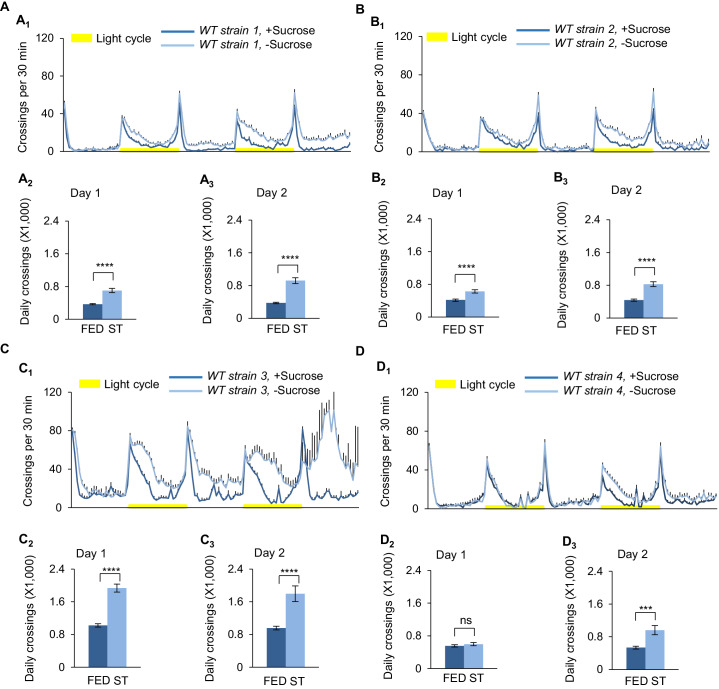
Starvation-induced hyperactivity across different wild-type fly strains.(A1, B1, C1, D1) Midline crossing activity of different wild-type strains assayed in the presence or absence of 5% sucrose (n = 46–63). (A2, B2, C2, D2) Average daily midline crossing activity in Day 1 of flies assayed in A1-D1. (A3, B3, C3, D3) Average daily midline crossing activity in Day 2 of flies assayed in A1-D1. ns, p>0.05; *p<0.05; **p<0.01; ***p<0.001. Strain 1: Oregon-R; Strain 2: Canton-S; Strain 3: a control strain from VDRC; Strain 4: a control strain from Bloomington. Note that for all these strains, most of the starved flies were dead after two days of starvation. Student’s t-test and one-way ANOVA followed by post hoc test with Bonferroni correction were used for pair-wise and multiple comparisons, respectively.